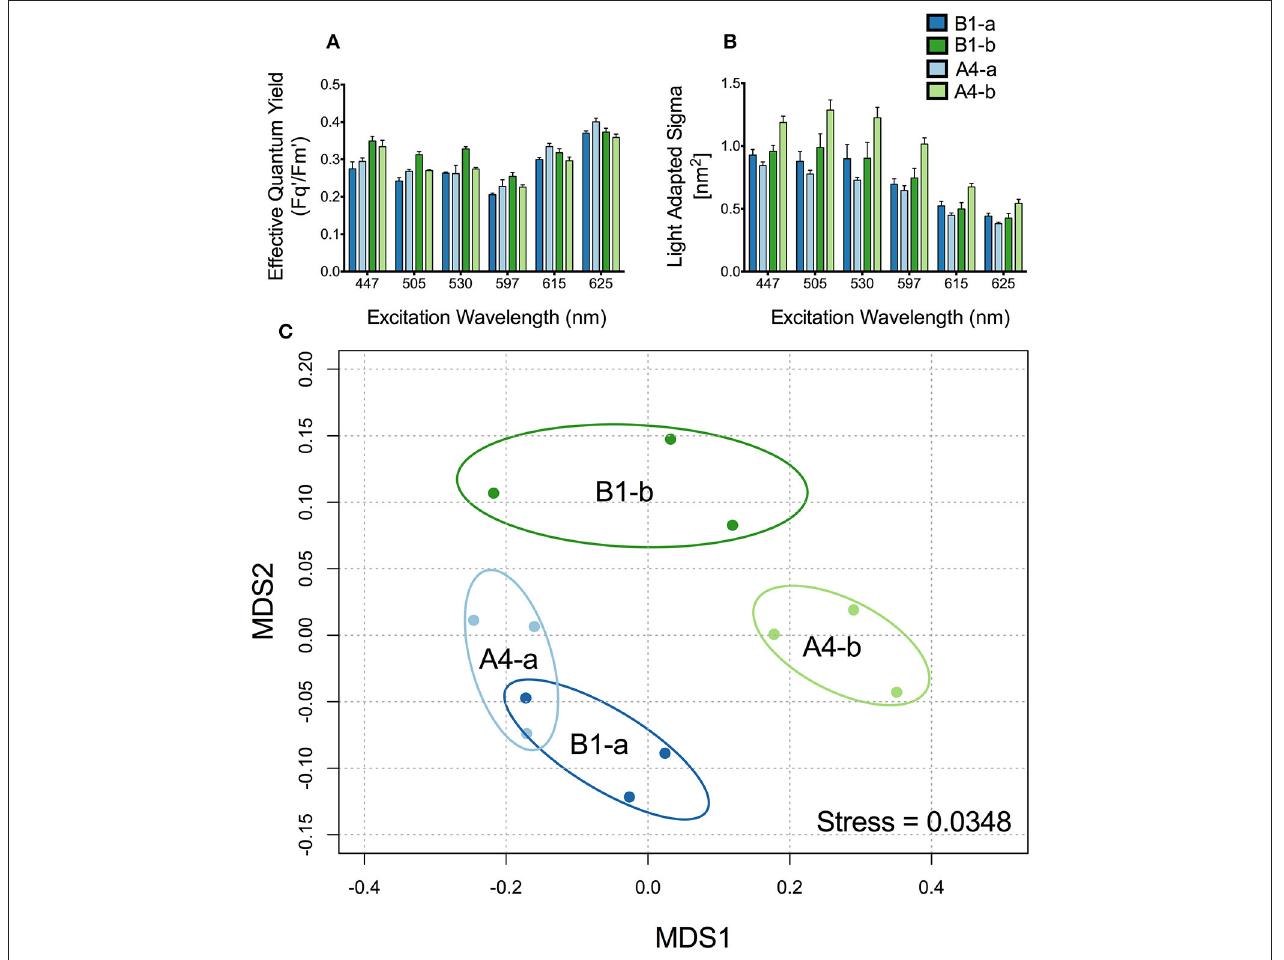
FIGURE 2 | Differences in fluorescence signature across symbiont types. (A) Effective quantum efficiency of PSII and (B) Light adapted absorption cross section ( σ PSII ) for (dark blue) B1-a, (light blue) A4-a, (dark green) B1-b, and (light green) A4-b. Bars represent the mean and ± SE for low light adapted samples. (C) Principle components analysis using light adapted σ PSII and Fv’/Fm’ for all four species. Ellipses represent a 95% confidence around the mean for each symbiont